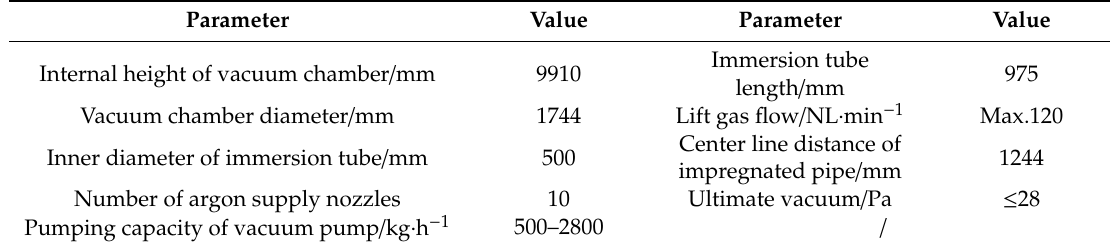
Table 2. Main technical parameters of 120 ton RH in the experimental steel plant.